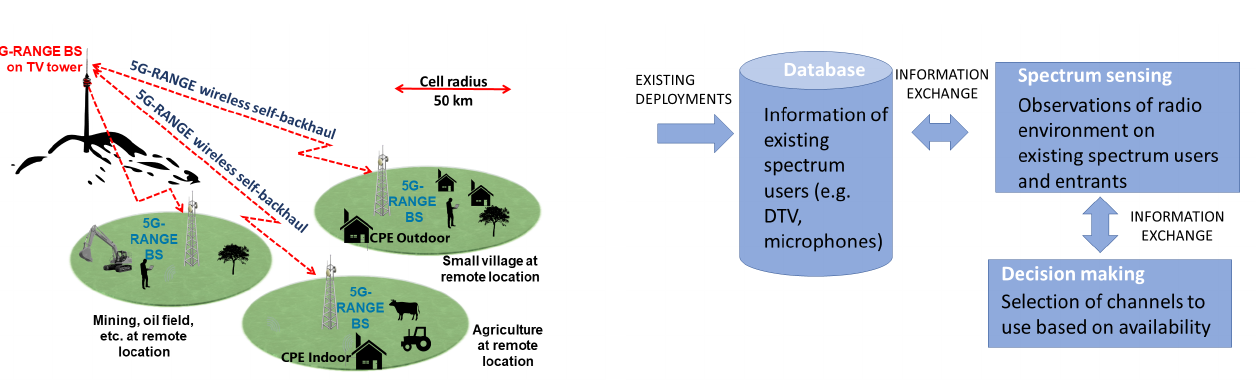
Figure 1. Example remote area scenarios. Figure 2. System model for spectrum sensing to complement database